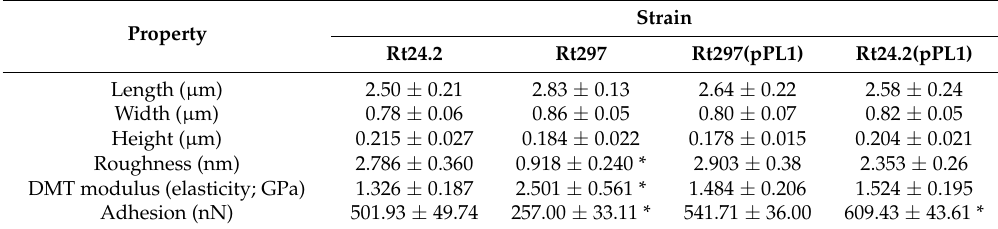
Figure 9. Atomic Force Microscopy (AFM) imaging of the wild-type strain R. leguminosarum Rt24.2 and its derivatives Rt297, Rt297(pPL1), and Rt24.2(pPL1). 3D images, height images, and section profiles corresponding to lines in the height images are presented (green and blue lines correspond to section profiles done in various planes of the cells). Table 3. Cell properties of the wild-type R. leguminosarum Rt24.2 and its derivatives determined using AFM